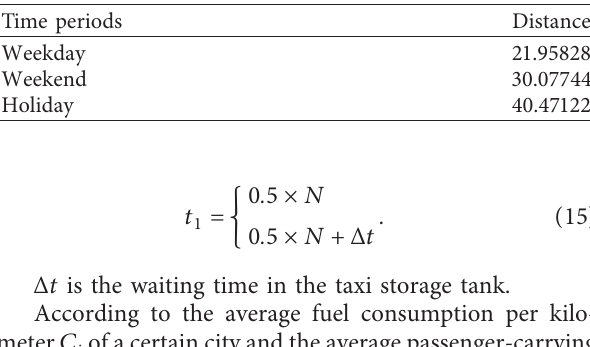
Figure 3: Flights arrivals in different periods. Table 8: Average carrying distances of taxis on different time periods